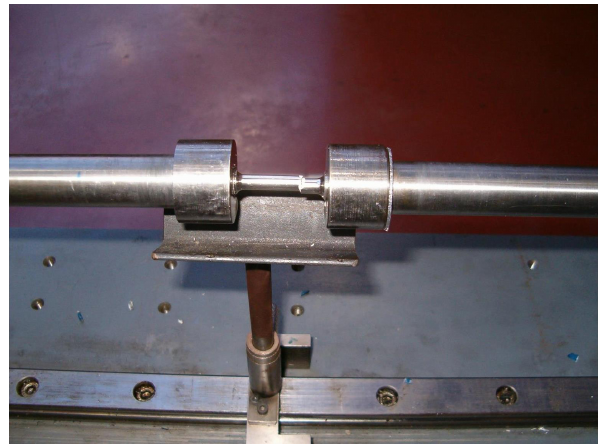
Figure 23. Experimental apparatus after the experiment when using 1mm thick damping rings.